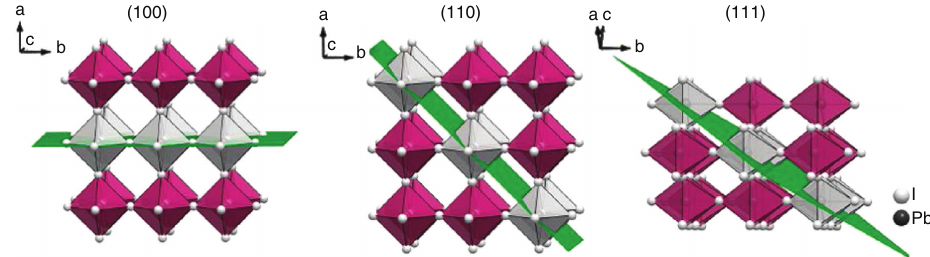
Figure 1: Derivation of 2D halide perovskites from the parental cubic perovskite lattice of 3D layered halide perovskites by cutting the latter along typical crystallographic planes: (100), (110), and (111). Reprinted from Ref. [79] with permission from the American Chemical Society.